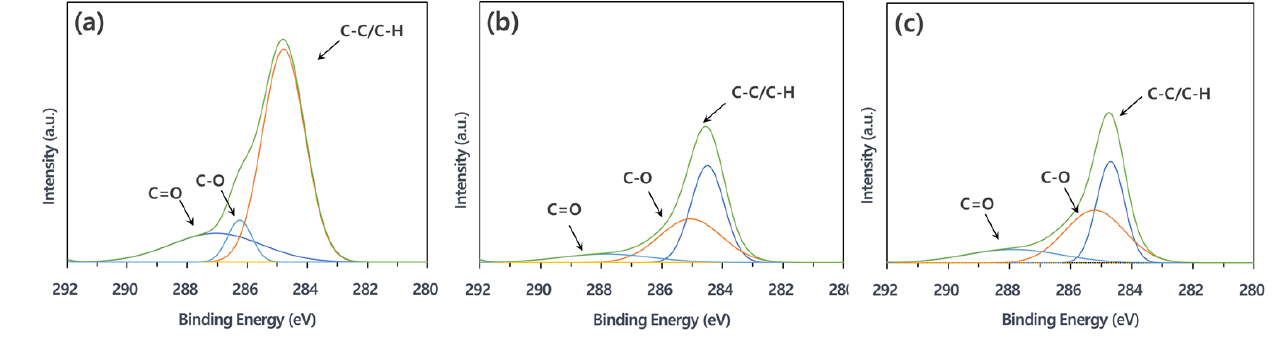
Table 8. The result of C1s XPS spectra of CM-DTHCs. Area (%)